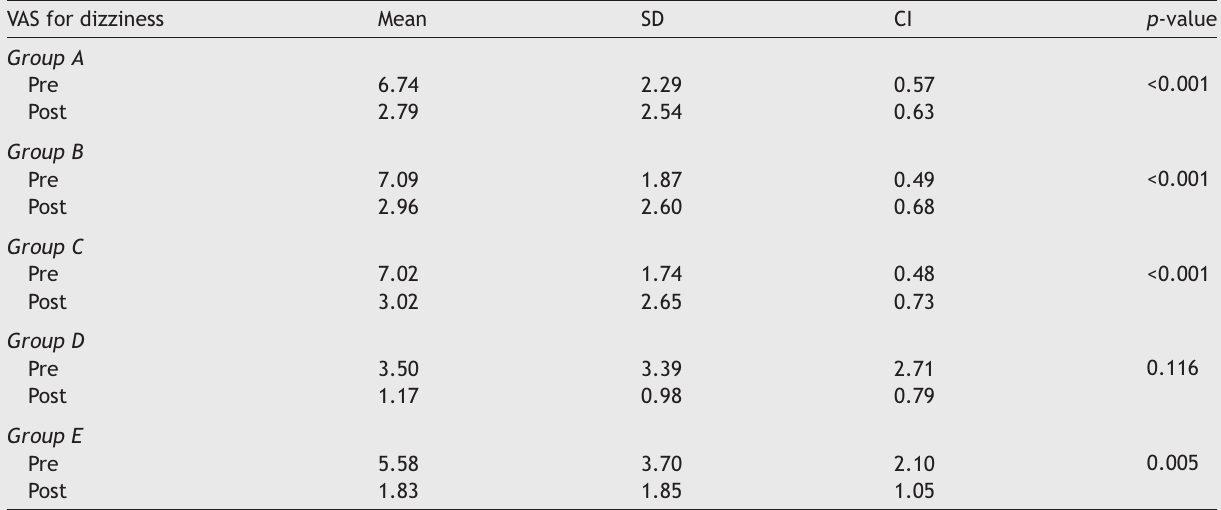
Table 6 Mean scores of the visual analogue scale for dizziness by subgroup of patients. VAS for dizziness Mean Group A